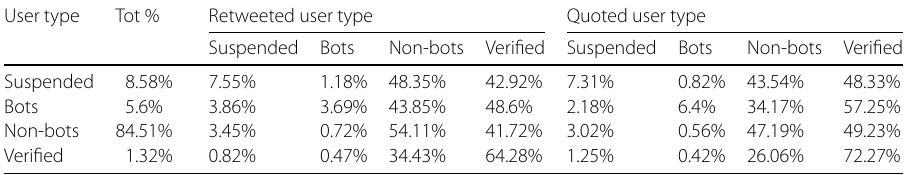
Table 1 Percentage of retweets and quote tweets by users, divided by type. Bots and suspended users are not very supportive of each other and their activity focuses on retweeting genuine accounts, thus generating noise and fostering discussions that are already present User type Tot % Retweeted user type Quoted user type Suspended Bots Non-bots Verified Suspended Bots Non-bots Verified Suspended 8.58% 7.55% 1.18%